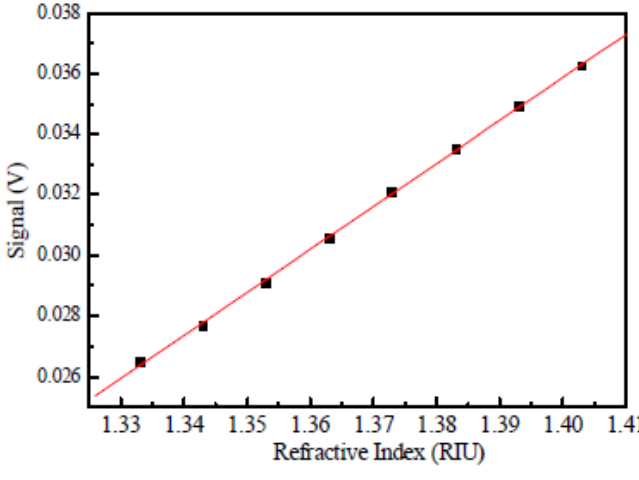
Figure 11. Plot of sensor response versus refractive index of the sucrose solution for a sensing fiber with five D-shaped zones.